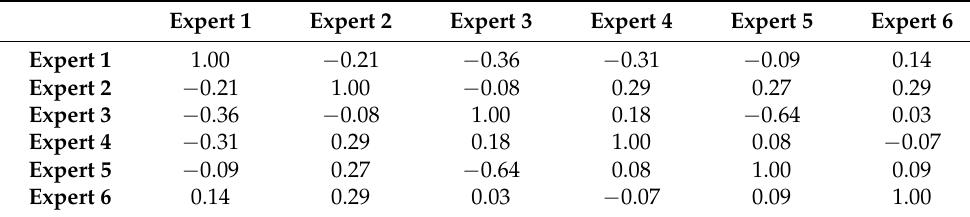
Table A5. Similarity index matrix of the experts for the competencies.